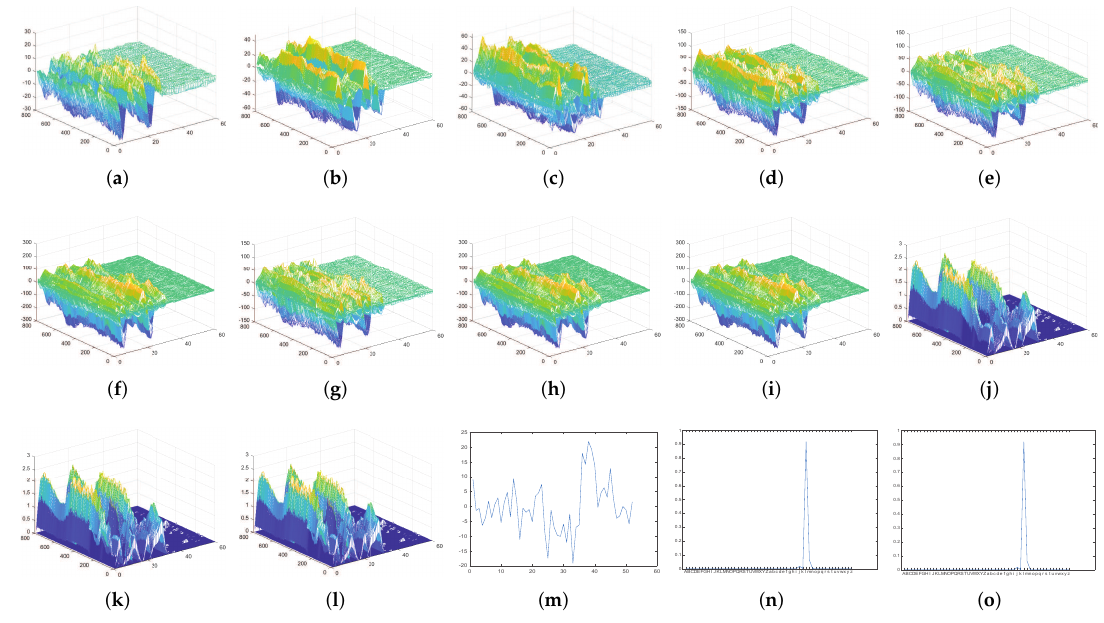
Figure 7. The output of all layers for lowercase letter ‘l’. ( a ) The output of Input layer. ( b ) The output of conv1 layer. ( c ) The output of conv2 layer. ( d ) The output of conv3 layer. ( e ) The output of conv4 layer. ( f ) The output of conv5 layer. ( g ) The output of Average-pooling layer in Inception moudle. ( h ) The output of Depth concatenation layer. ( i ) The output of Batch normalization layer. ( j ) The output of ReLU layer. ( k ) The output of Average-pooling layer. ( l ) The output of Dropout layer. ( m ) The output of Fully-connected layer. ( n ) The output of Softmax layer. ( o ) The output of Classification